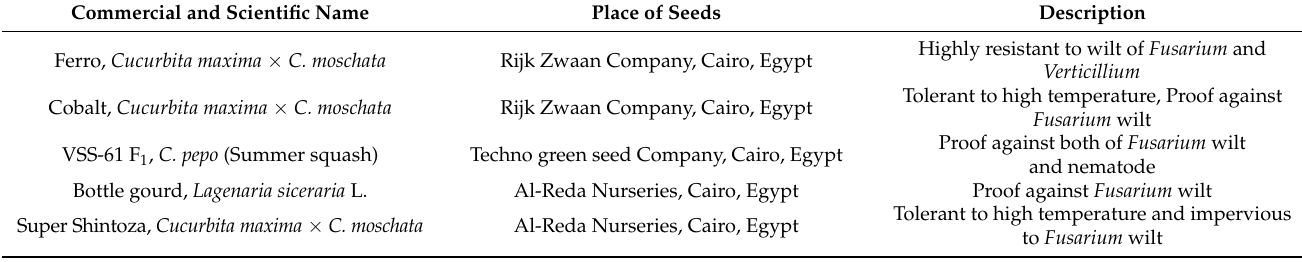
Table 4. Details of five cucurbit rootstocks used in our study.